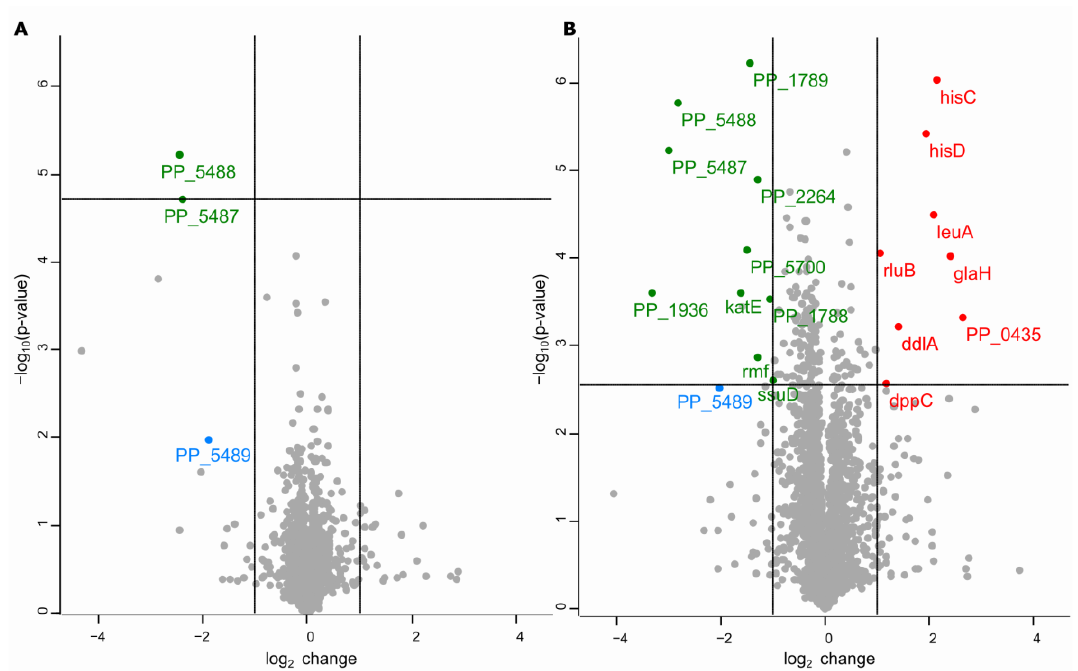
Figure 4. Overview of P. putida wild-type and rluA ( A ) or truA ( B ) mutant full proteome comparison. In volcano plot every dot represents a protein. The horizontal line indicates the statistical significance threshold after Benjamin–Hochberg multiple testing correction [false discovery rate (FDR) = 0.05]. The vertical lines indicate twofold difference between compared proteomes. Statistically significant at least two-fold increase in protein level are presented as red dots with the gene name and at least two-fold decrease in protein level are presented as green dots. Blue dot represents the third protein of PP5487-PP5489